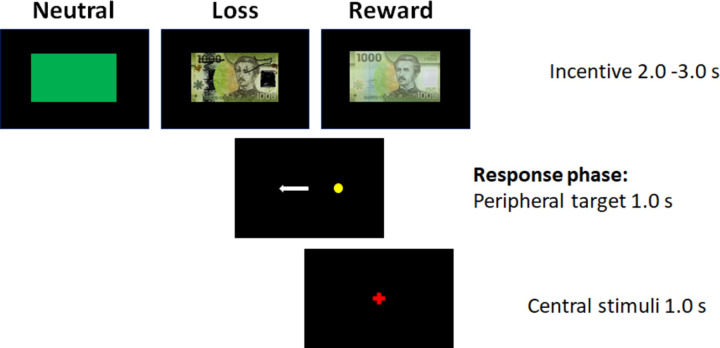
Experimental design of the incentivized antisaccade task.Each trial began with the presentation of an incentive (reward, loss avoidance or neutral), response phase, and a central stimulus.